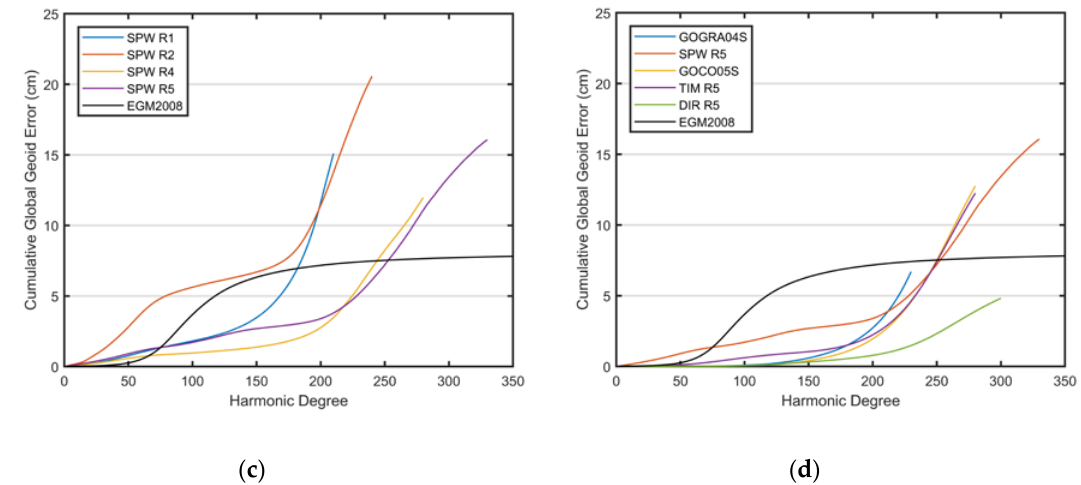
Figure 1. Error amplitudes (accumulated) as a function of the spherical harmonic degrees “ (cid:96) ” in terms of geoid heights: ( a ) direct (DIR RLx) models; ( b ) time-wise (TIM RLx) models; ( c ) space-wise (SPW RLx) models; ( d ) GOGRA04S, GOCO05S and EGM2008 models.